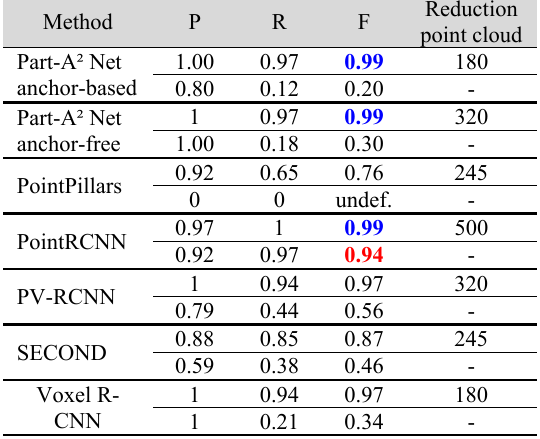
Table 5 . Best detection results on different thinned point clouds and original point clouds are displayed bold. P: precision; R: recall; F: F1